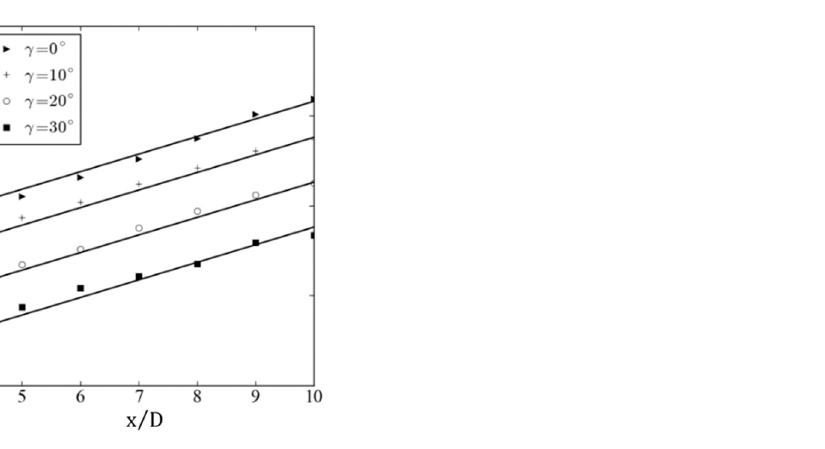
Figure 7. Variation of the normalized standard deviation of the velocity deficit profiles for different yaw angles. Fitted lines are denoted by black solid